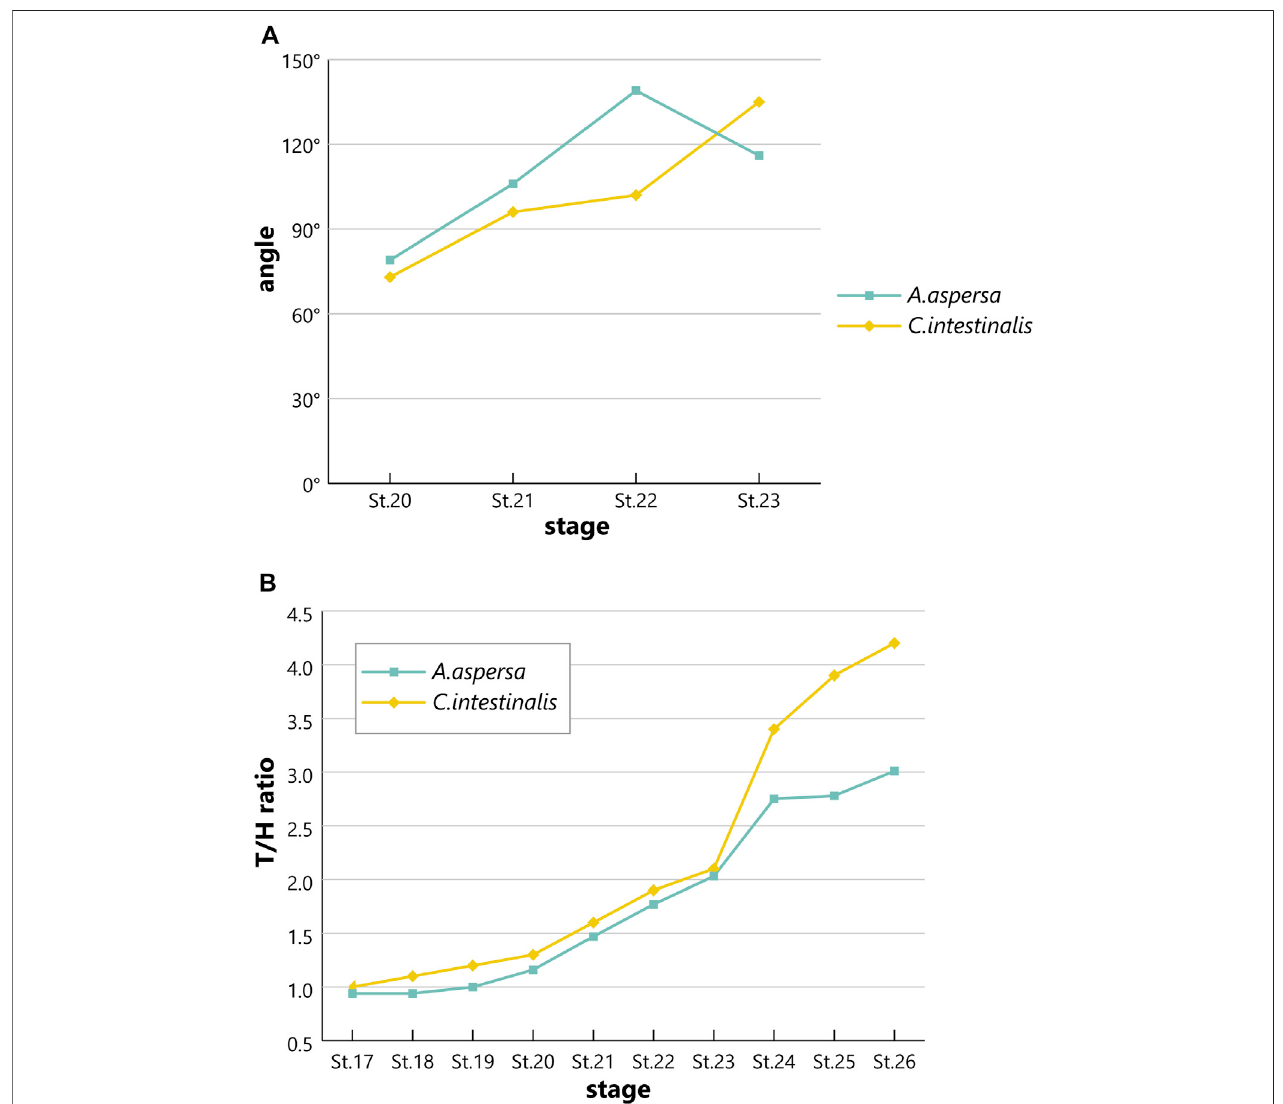
FIGURE11| Comparison ofbendingangle ortail/headratiobetween A . aspersa and C . intestinalis typeAattailbud andlarvalperiods. (A) Bending anglebetween the tail and the trunk at Stage 20 – 23. (B) The ratio of the trunk and tail length at Stages 17 – 26.